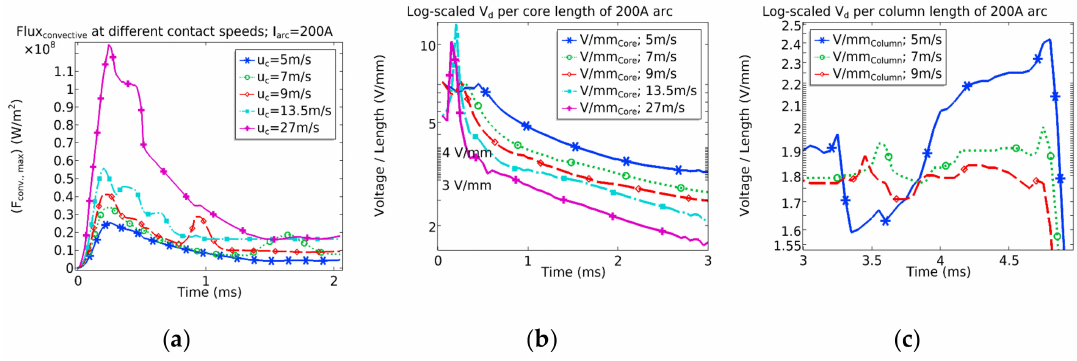
Figure 17. ( a ) Max. convection flux for 200 A arc at u c = 5, 7, 9, 13.5, 27 m / s. Voltage per length of arc for ( b ) the first 3 ms for 200 A arcs and u c of 5, 7, 9, 13.5 and 27 m / s, and ( c ) the last 2 ms for 200 A arcs and u c = 5, 7, 9 m /